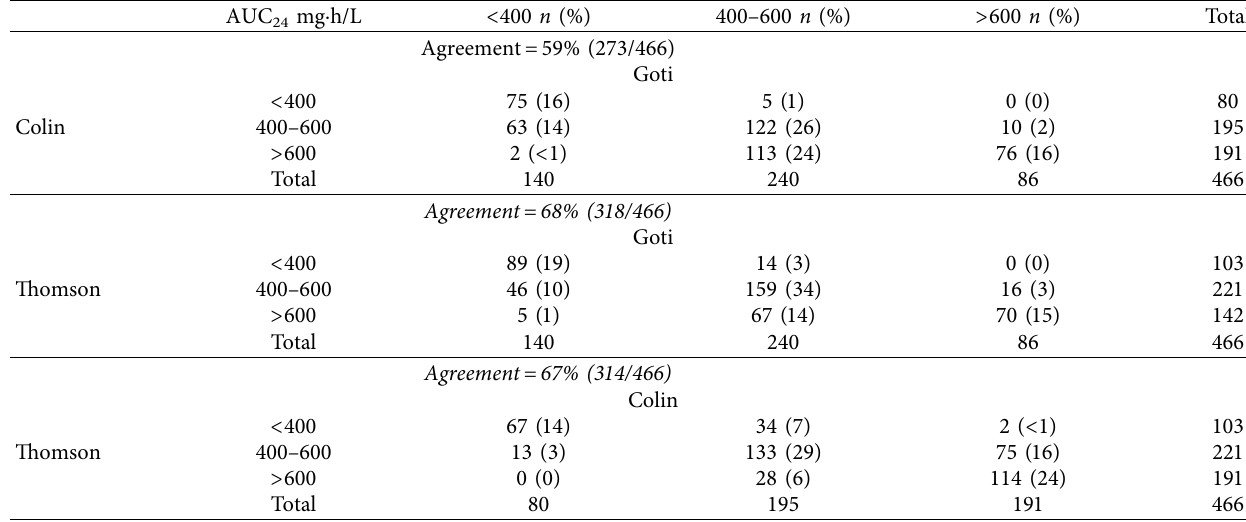
Table 2: Agreement between models at decision cut-ofs.